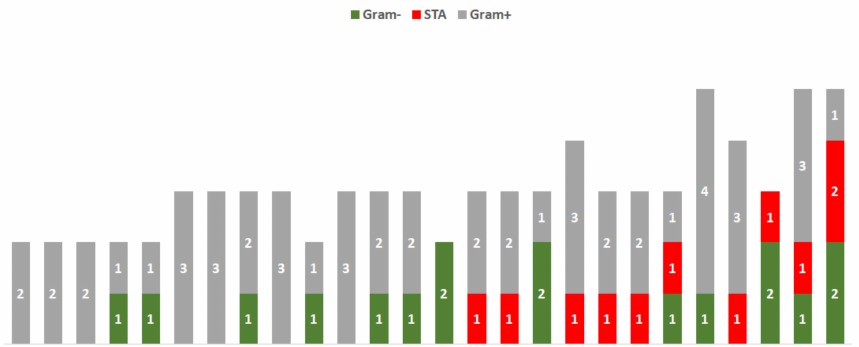
Figure 3. Prevalence of infectious agents in semen samples belonging to the Test group. Each histogram represents a single semen sample: the presence of Gram-positive bacteria was found in 24 samples (in gray), 13 Gram-negative (in green), and 10 sexually transmitted agents (STAs, in red). In the Control group, just 31.2% (5/16) of the samples presented with an infective value greater than three. The microbiological agents identified in the two analyzed groups are reported in Figure